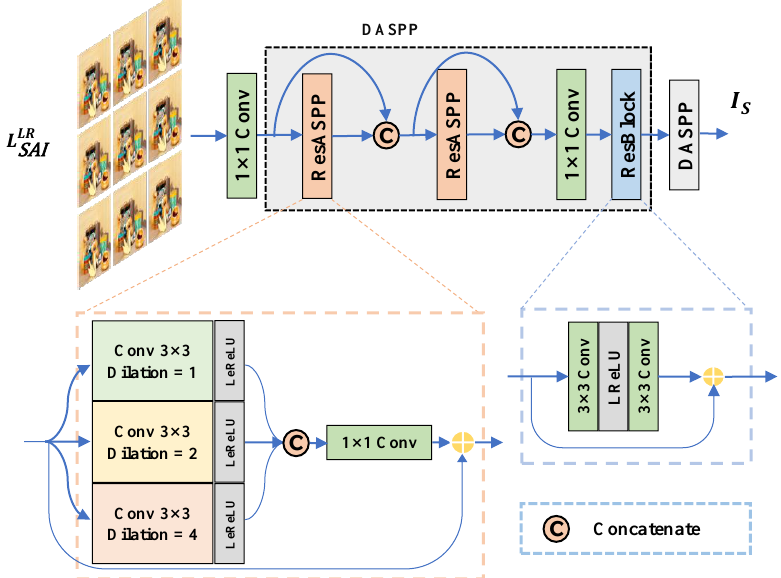
Figure 3. Detailed illustration of feature extraction module (FEM). The dense atrous spatial pyramid pooling (DASPP) is the main component of FEM. These two dotted boxes show the details of residual atrous spatial pyramid pooling (ResASPP) and residual block (ResBlock). Concatenate (C) represents the operation of feature